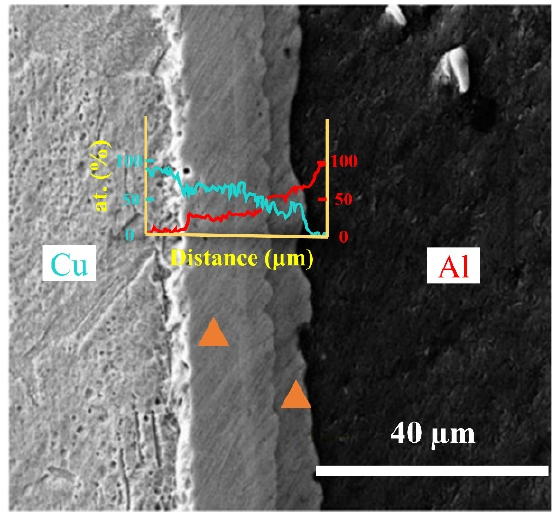
Figure 3. The SEM images of the Al–Cu interface (blue and red lines denote the at.% of Cu and Al, respectively) with locations of the EPMA (highlighted in the triangles).